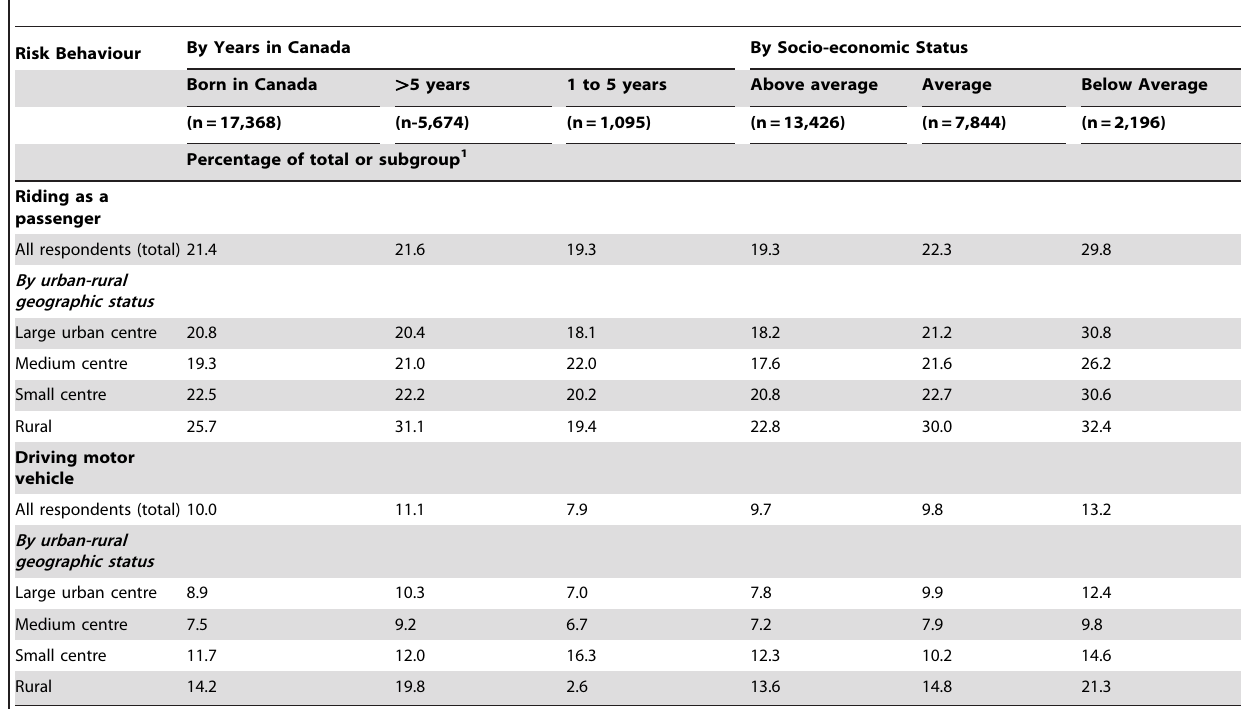
Table 3. Percentage of young adolescents reporting any use of alcohol, marijuana or other illicit drugs by driver while in a car or other motor vehicle, 2010 Canadian HBSC by years in Canada and socio-economic status.